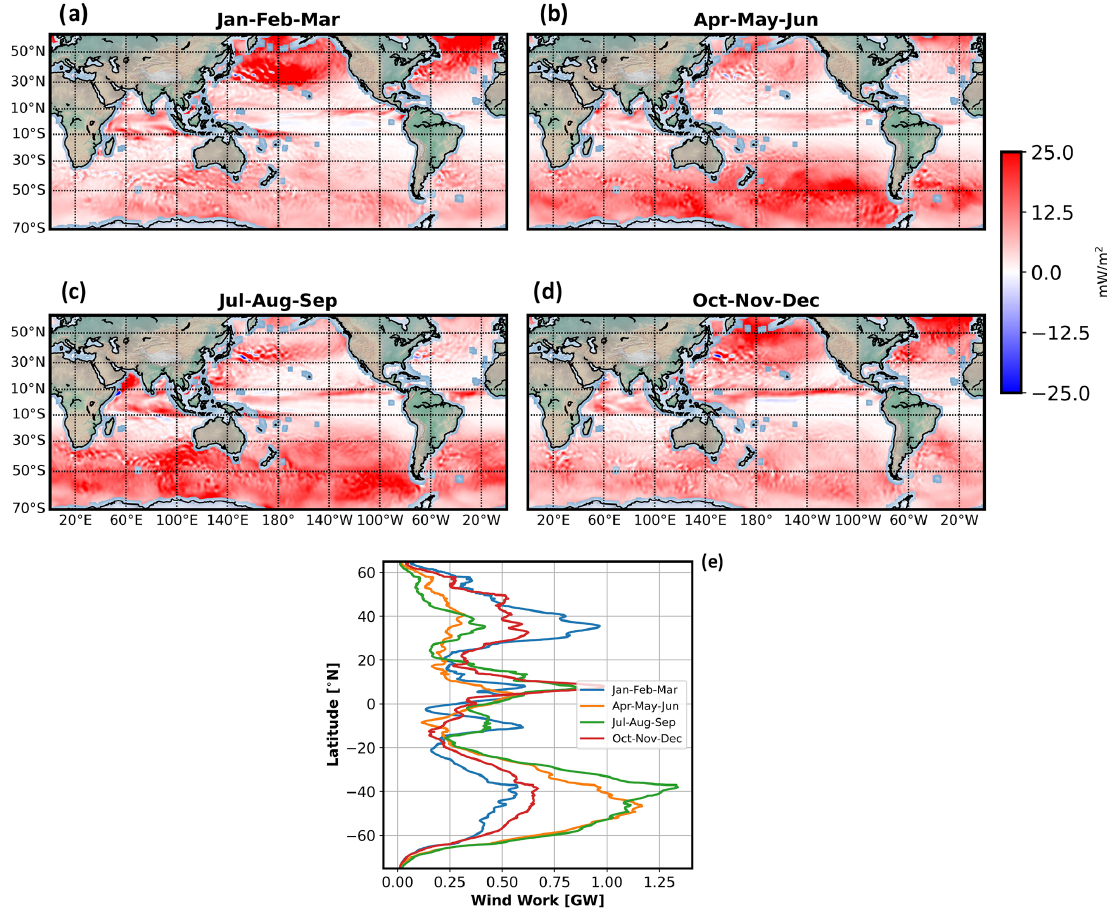
· u o (cid:48) . (e) Wind work lf > lf >